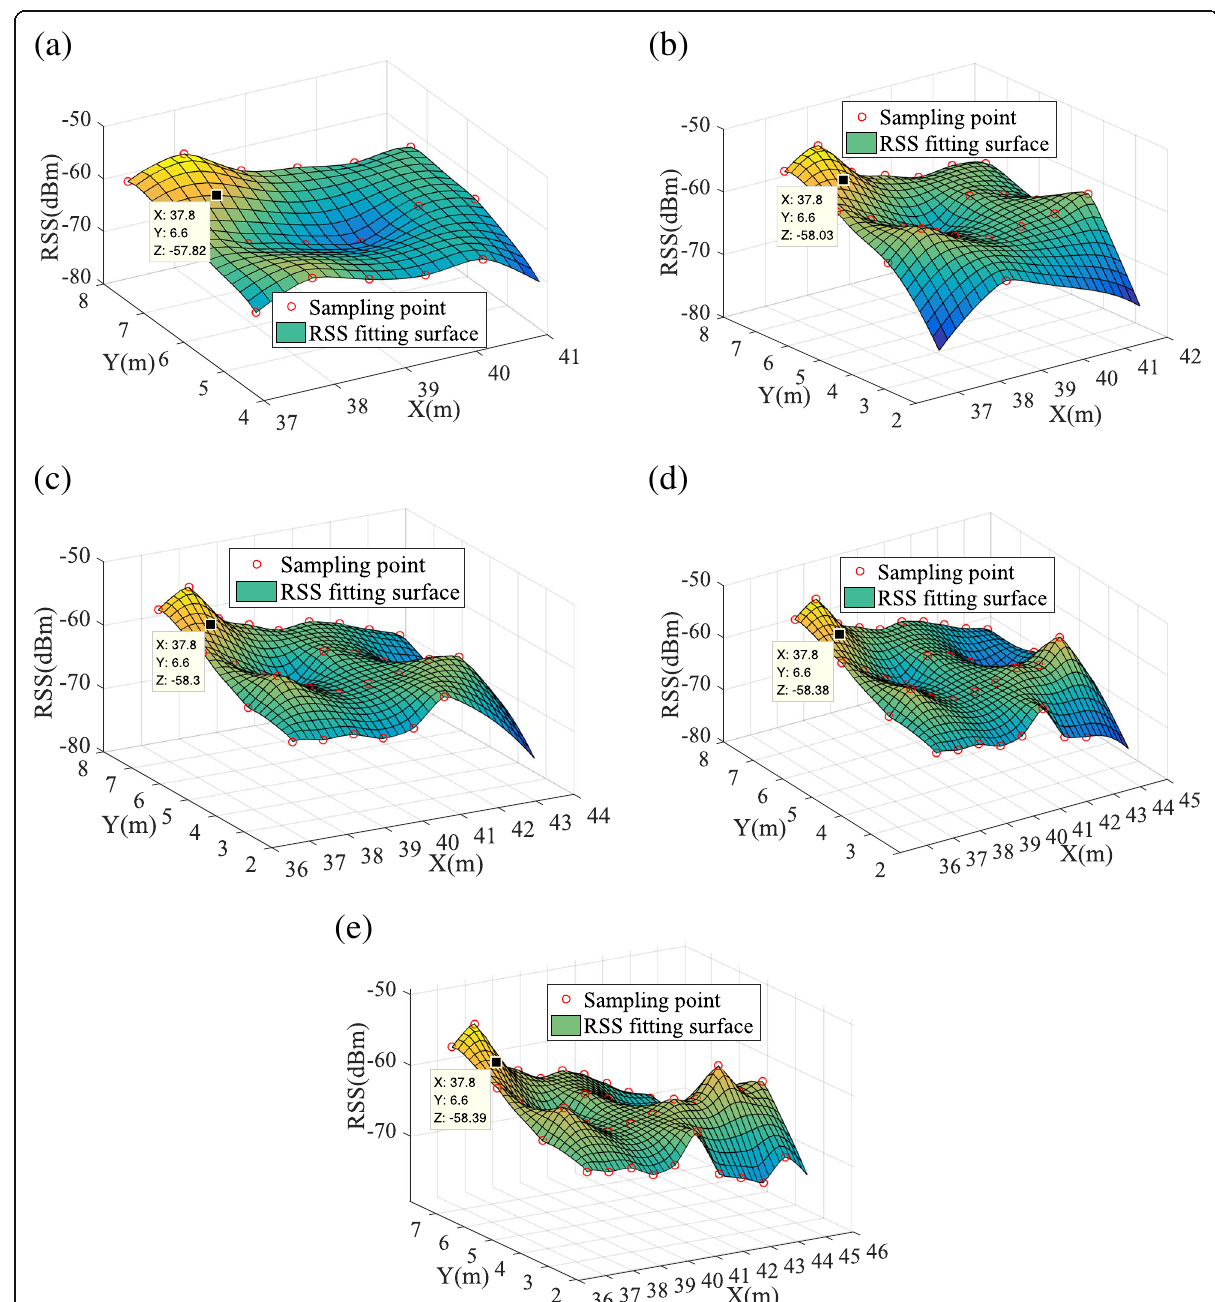
Fig. 9 RSS surfaces corresponding to different radius. a R = 3 m. b R = 4 m. c R = 5 m. d R = 6 m. e R = 7